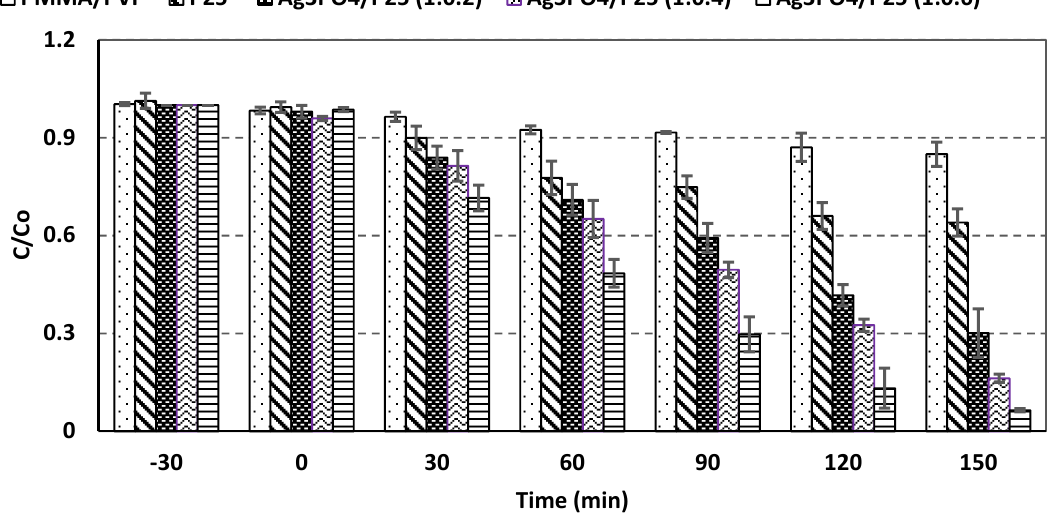
Figure 6. Methyl orange (MO) photocatalytic degradation under simulated sunlight using PMMA / PVP, P25, PMMA: Ag 3 PO 4 / P25 ratio (1:0.2) (1:0.4) and (1:0.6).